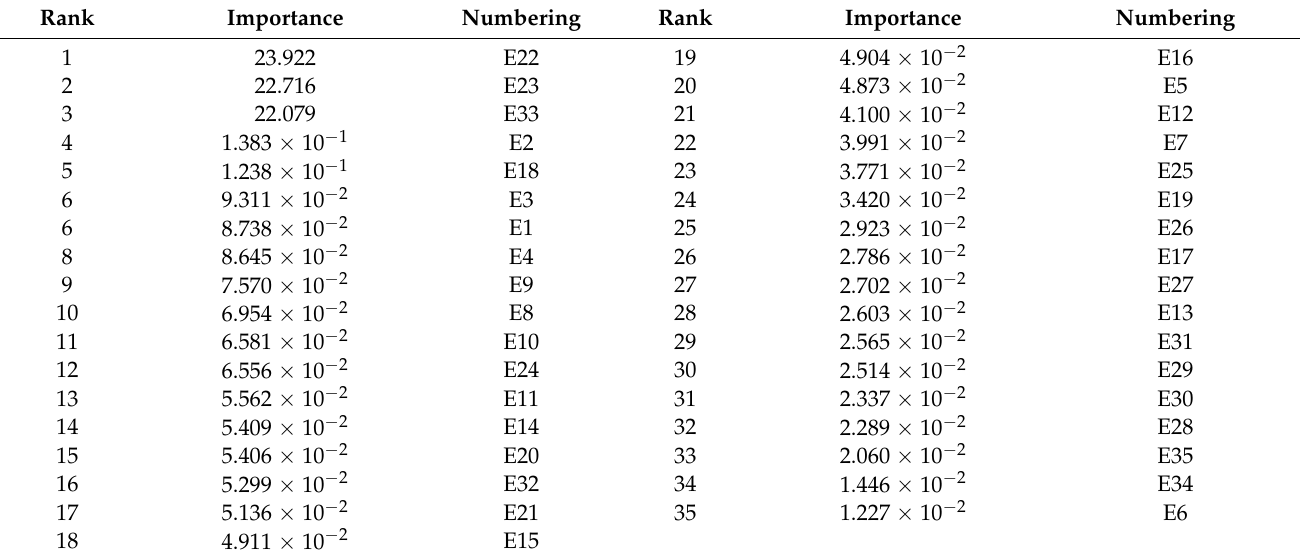
Table 14. Importance and ranking of basic